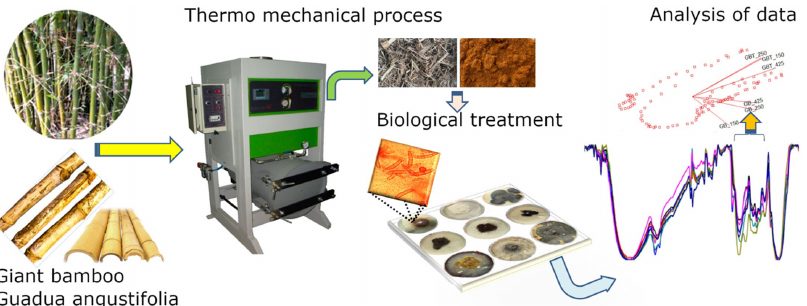
Figure 1. Eco-friendly proposal to modify the chemical structure of lignocellulosic compounds and break down the lignin linkages in natural fibers.